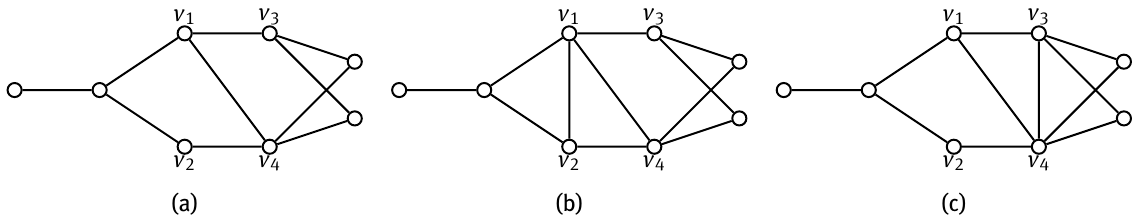
Figure 3: (a) A graph G with co-transmission cousin pair { v 1 , v 2 } , { v 3 , v 4 } . The graphs shown in (b) and (c) are the two